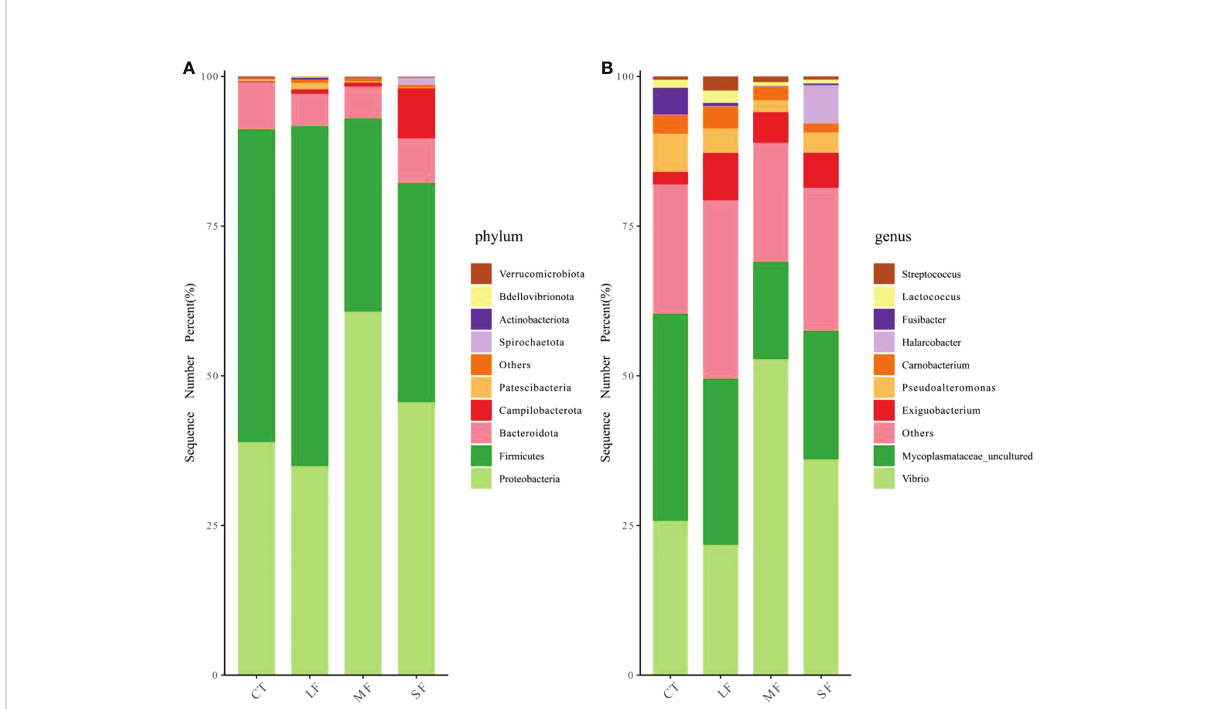
FIGURE 8 Relative abundance of bacterial communities at the gut microbiota phylum (A) and genus (B) level in juvenile crabs at different levels of DTF (28 °C, 28 ± 2°C, 28 ± 4°C, 28 ±